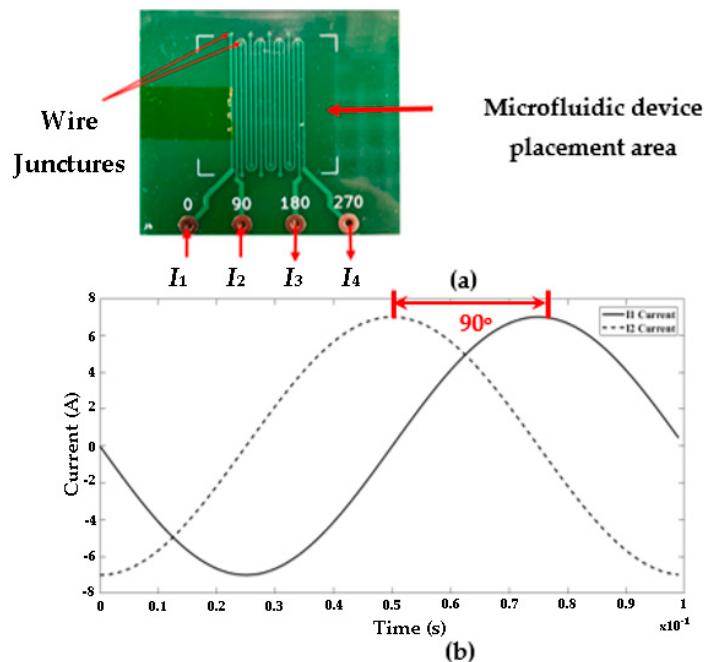
Figure 1. Overview of the programmable chip platform and current waveform: ( a ) Photo of the first fabricated programmable electronic chip base. The arrows going in represent the current amplitudes supplied to the chip at a 90° phase, and the arrows coming from the chip represent the output currents at a 90° phase di ff erence. ( b ) The current sinusoidal input current waveforms for I 1 and I 2 .